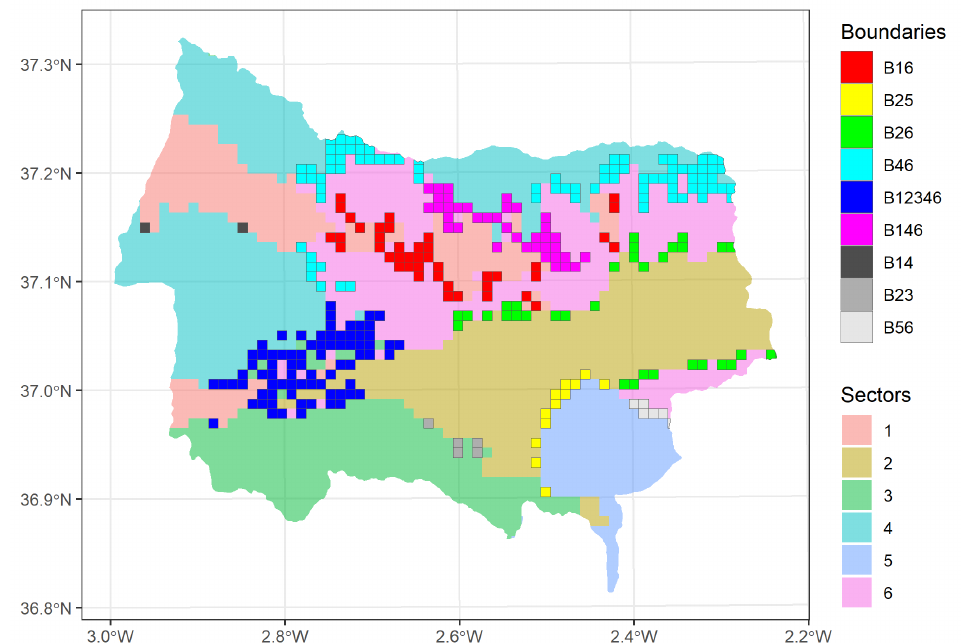
Figure 5. Boundary zones according to the sector they separate (marked in different